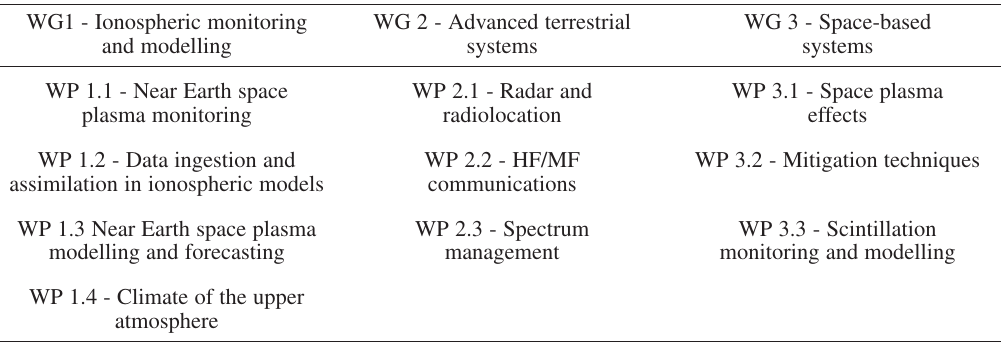
Table I. COST 296 action